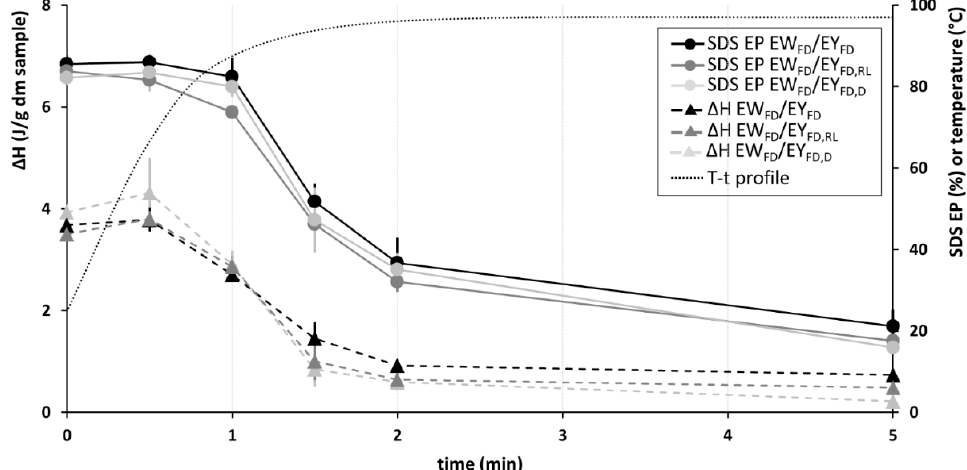
Figure 3. Enthalpy ( Δ H, expressed in J/g dry matter (dm)) of the endothermic transition during differential scanning calorimetric (DSC) analyses and the percentage of protein extractable in sodium dodecyl sulfate containing medium (SDS EP) of heated + defatted sponge cake batter samples prepared from recipes containing different egg yolk treatments prior to batter preparation. Sample codes are shown in Table 1. For heating times exceeding 5 min, parameters remained constant. Vertical bars indicate standard deviations. Temperature − time (T-t) profile was measured using the Datapaq setup.